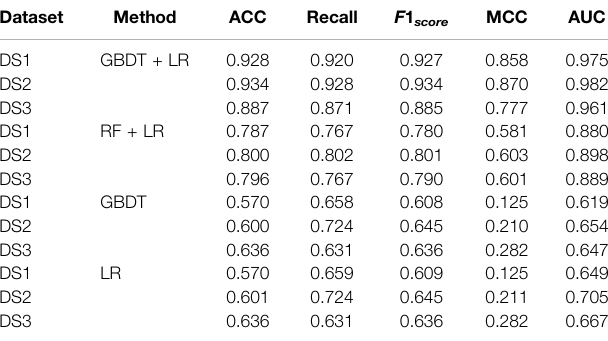
TABLE 3 | Comparison of prediction performance using other machine learning methods. Dataset